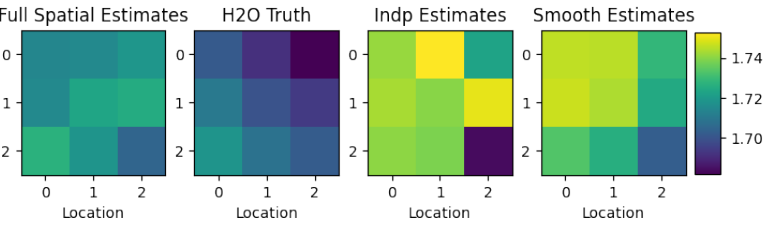
Figure 4. Inversions of simulated data showing the water vapor estimates (units of g/cm 2 ) across 9 pixels on a 3 × 3 grid. The spatial field better represents the truth; smoothing cannot overcome the bias in the independent